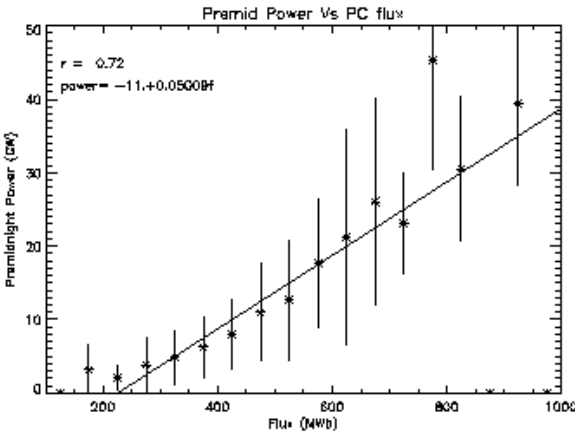
Fig. 2. Correlation of polar cap flux with premidnight auroral power. Bins with no data are plotted as zeros but not included in the fit (which is to the original sample